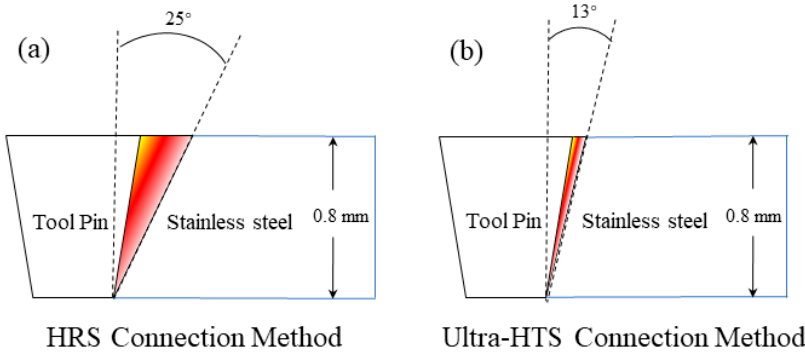
Figure 11. ( a ) Schematic diagram of shear band thickness under HRS-FSW parameter, ( b ) schematic diagram of shear band thickness under an ultra-HRS-FSW parameter.